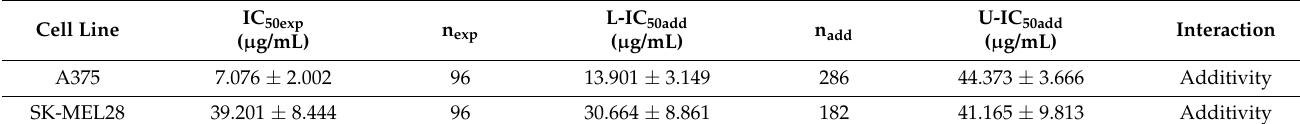
Table 2. Type I isobolographic analysis of interactions for non-parallel concentration–response relationship lines between amantadine and CDDP at the fixed drug concentration ratio of 1:1 in two melanoma cell lines A375 and SK-MEL28. Results are median inhibitory concentrations (IC 50 values in µ g/mL ± S.E.M.) for two-drug mixtures, determined either experimentally (IC 50exp ) or theoretically calculated (IC 50add ) from the equations of additivity, blocking proliferation in 50% of tested cells in two melanoma cell lines (A375 and SK-MEL28) measured in vitro by the MTT assay. L-IC 50 —lower additive IC 50 value, U-IC 50 —upper additive IC 50 value.